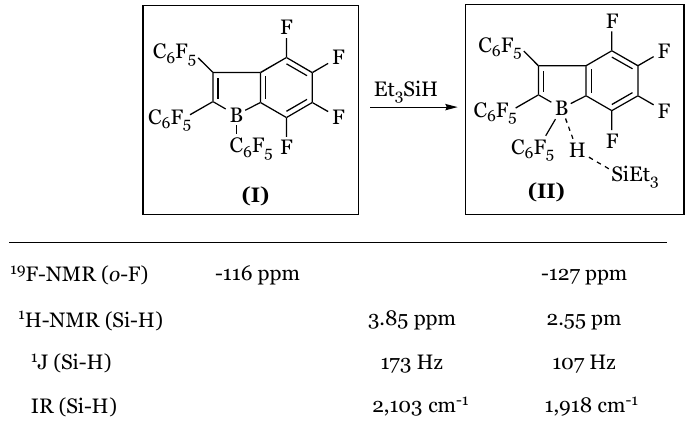
Figure 38. Spectral evidence for borane-silane complex formation.